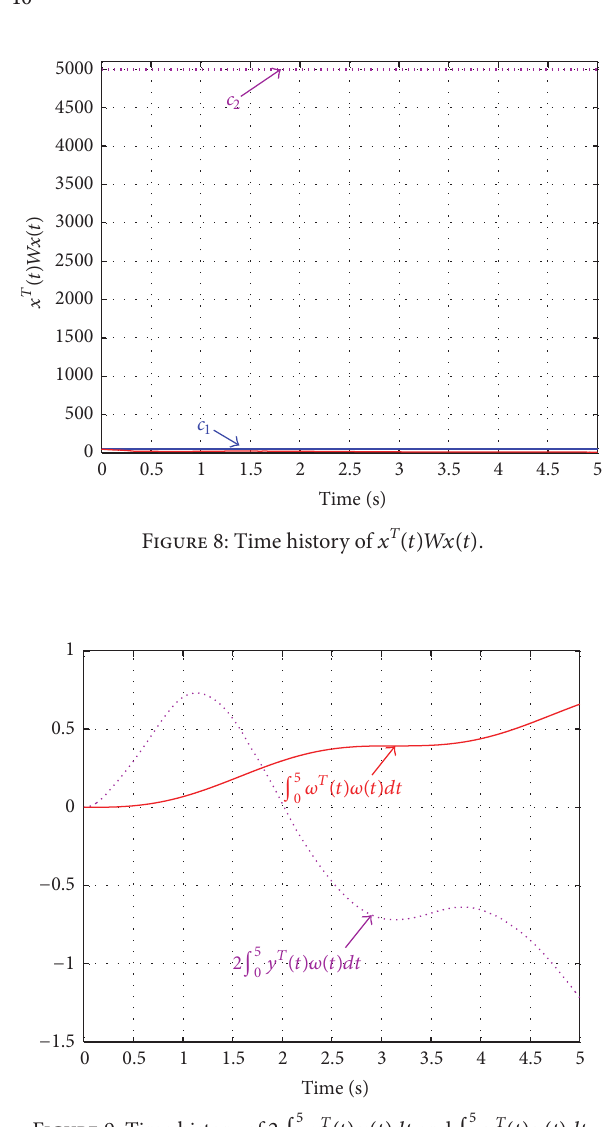
Figure 9: Time history of 2 ∫